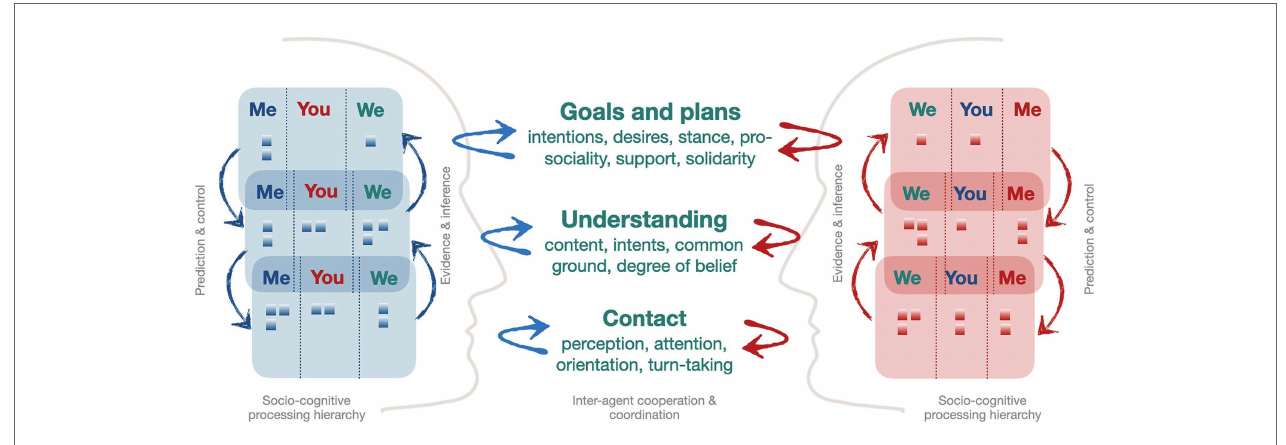
FIGURE 2 | A multi-layer model of cooperative human-agent interaction based on mentalizing and incremental, joint